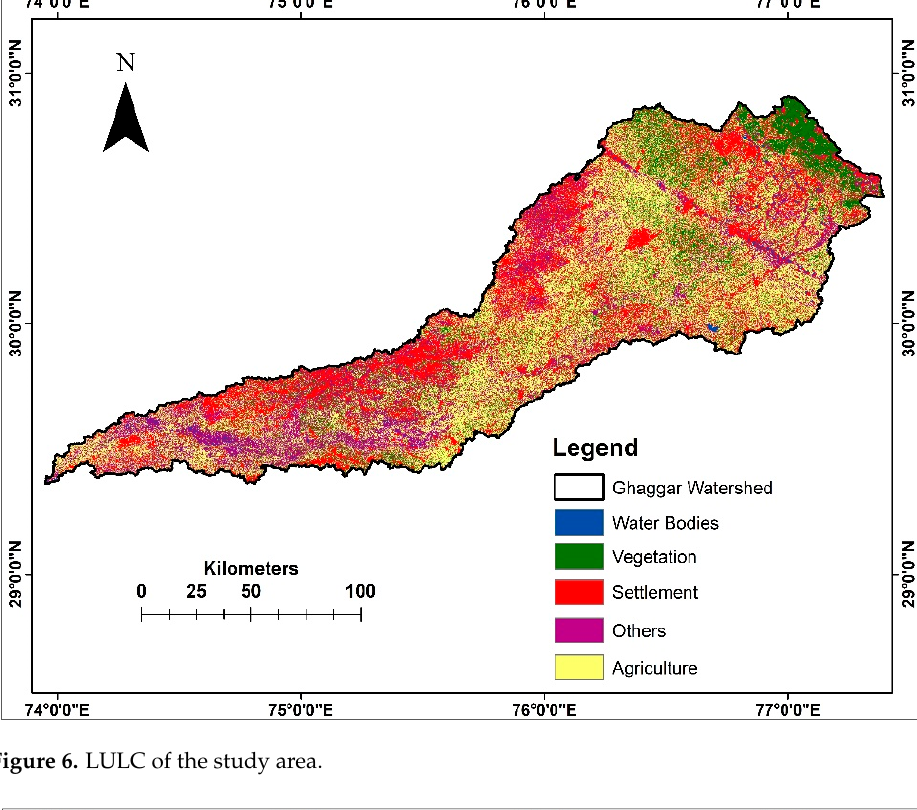
Figure 6. LULC of the study area.